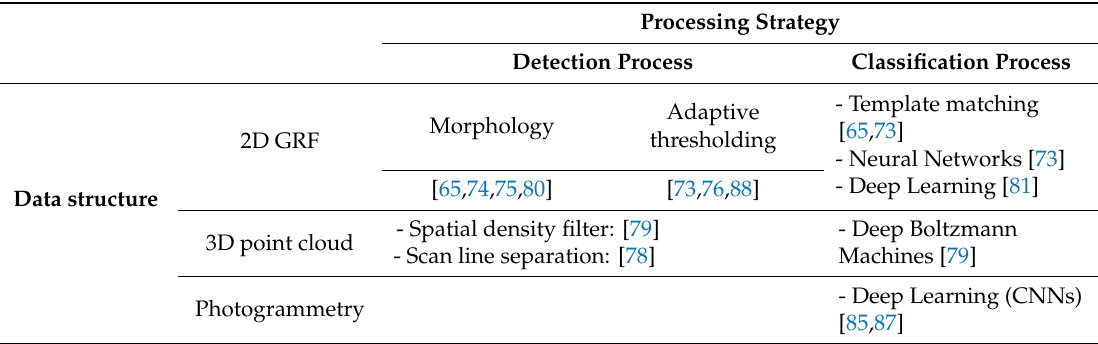
Figure 4. Road markings and driving lanes. ( a ) Soil á n et al. [73] apply an intensity filter on the point cloud (left) and generate a 2D GRF image representing the road markings (right). ( b ) Yan et al. [78] propose a scan line-based method using the gradient of point intensity to detect road marking points on each scan line (left) and generate a 2D GRF image representing the road markings (right). Table 3. Summary of state-of-the-art works for road marking